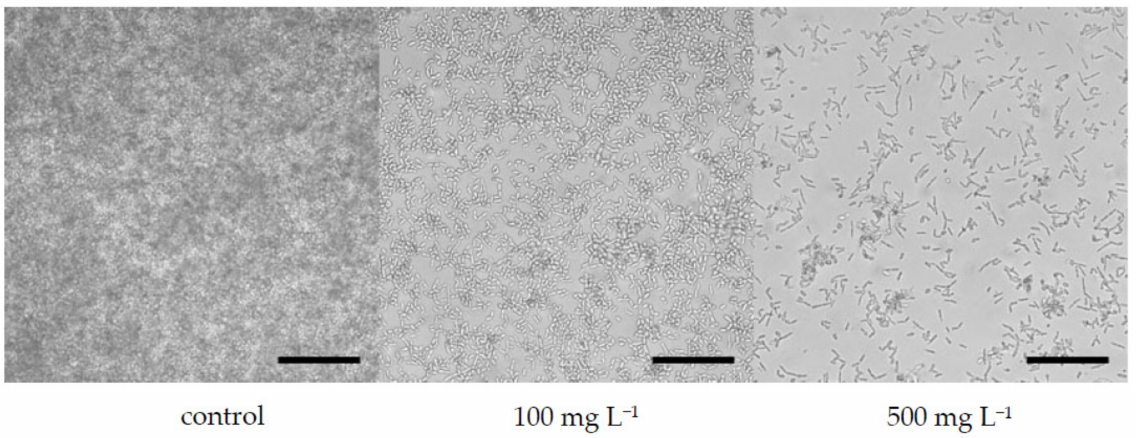
Figure 3. Effect of Bioswellix on C. albicans ATCC 2091 biofilm formation (visualized by a Cellavista device), scale bar 100 µ m.